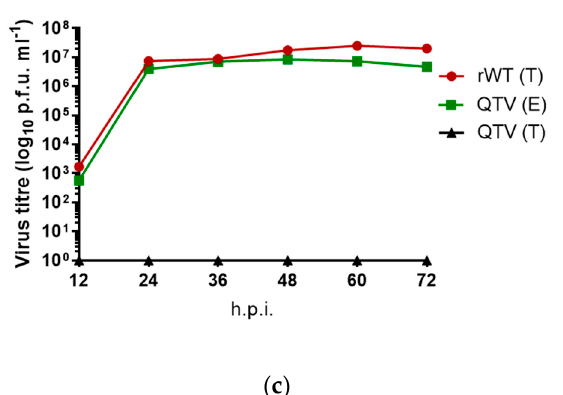
Figure 2. The generation and characterization of the reassortant mutant QTV virus in relation to its replication-dependency and kinetics. (a–b) The replication-dependency of reassortant wild type (rWT) and reassortant mutant QTV viruses. MDCK cells were infected at an m.o.i. of 0.001 in the presence of 1 µ g / mL TPCK-trypsin, 0.5 µ g / mL human neutrophil elastase, or in the absence of an exogenous protease. The supernatant and cells were harvested at 48 h.p.i., and underwent either plaque assay ( a ) or Western Blotting ( b ) to detect the presence of nucleoprotein (NP) and matrix (M1) proteins. ( c ) The replication curve of the rWT and QTV viruses on MDCK cells. The cells were infected with the respective virus at an m.o.i. of 0.001 with either 1 µ g / mL TPCK-trypsin (T) or 0.5 µ g / mL human neutrophil elastase (E). The reassortant mutant QTV virus was also tested in the presence of TPCK-trypsin. The supernatants were collected at specified time points until 72 h.p.i., and then titered by plaque assay on MDCK cells.